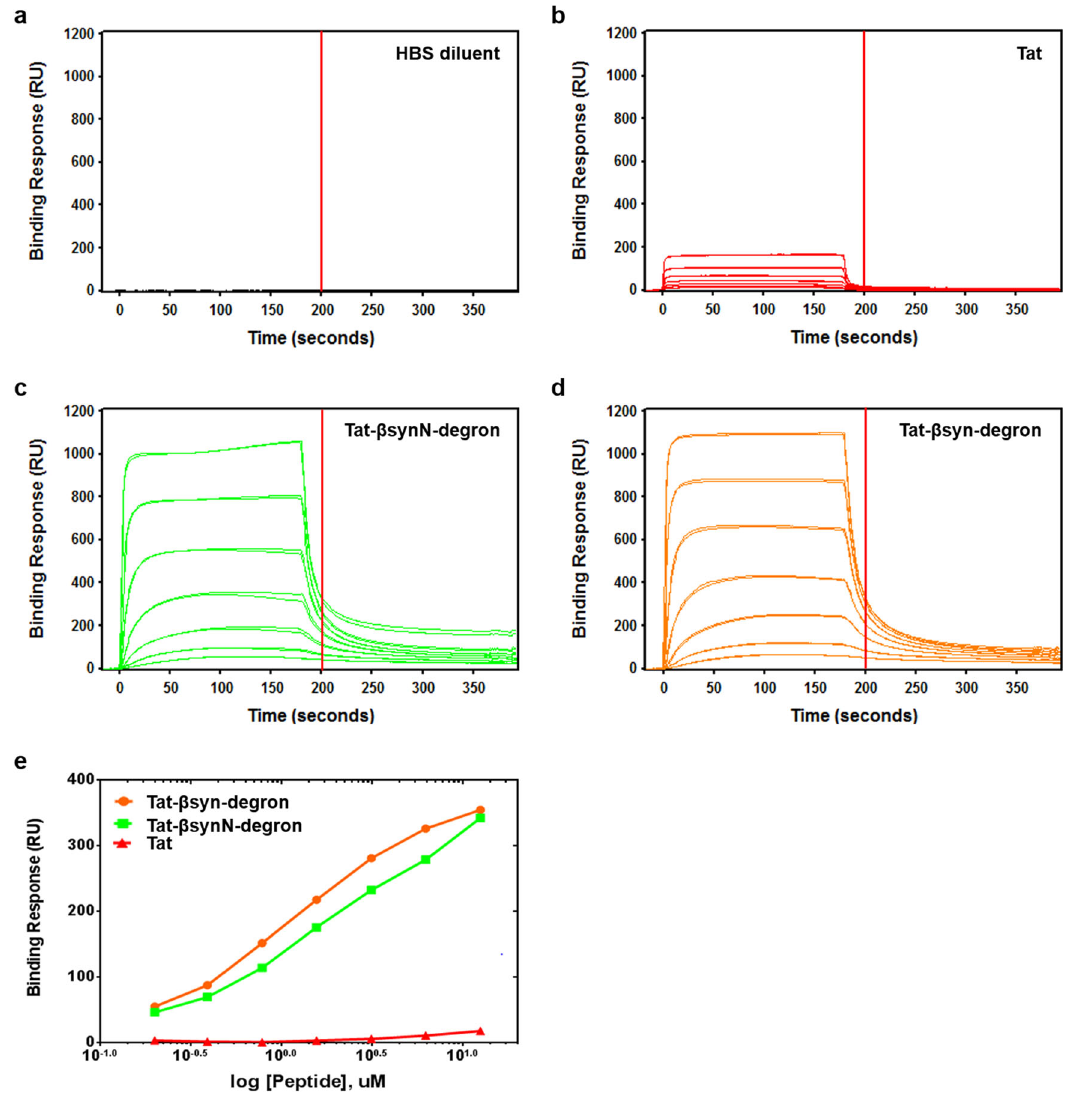
Fig. 2 Biacore peptide – protein binding assays. a – d Representative sensorgrams demonstrating the binding responses of the synthetic Tat peptide ( b ), Tat- β synN-degron peptide ( c ), Tat- β syn-degron peptide ( d ), or HBS blank buffer control ( a ) to α -synuclein. Two-fold serial dilutions (0.20, 0.39, 0.78, 1.56, 3.13, 6.25, 12.50 µ M) of peptides, in duplicate, were sequentially injected over immobilized puri fi ed recombinant human α -synuclein for 3 min, followed by a dissociation phase during which HBS buffer was fl owed over the surface. Sensorgrams, depicting binding responses over time, were double-referenced by subtracting out the binding on the reference surface and the response from the HBS blank buffer control. Peptide – α -synuclein-binding response report points were collected 20 s into the dissociation phase at time 200 s (as indicated by the vertical lines in the fi gures), to exclude bulk refractive index changes and nonspeci fi c binding. e Graphing of peptide – α -synuclein-binding response vs. peptide concentration showing that synthetic Tat- β synN-degron and Tat- β syn-degron peptides displayed robust and similar binding with α -synuclein in a dose-dependent manner (0.20, 0.39, 0.78, 1.56, 3.13, 6.25, 12.50 µ M), while the control Tat peptide displayed little binding with α